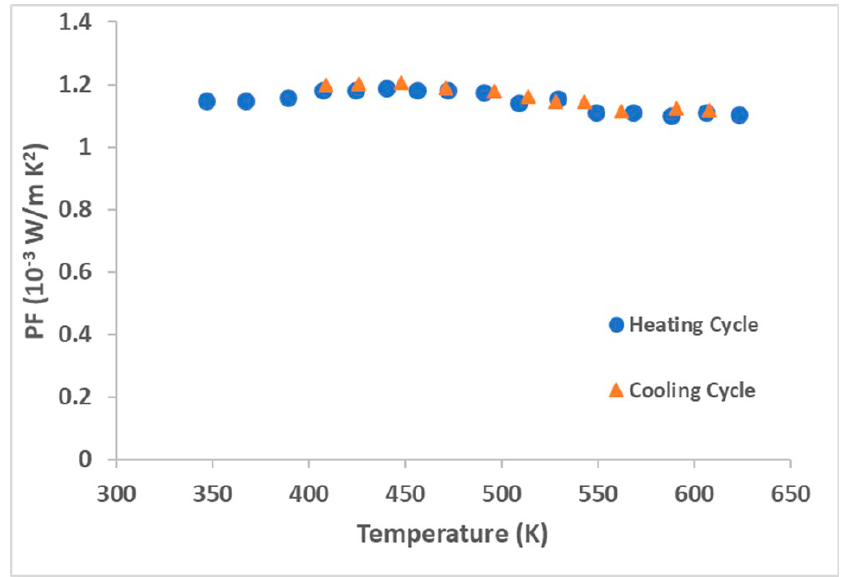
Figure 10. Power factor (PF) of hot extruded ZnSb sample in a heating / cooling Figure 10 . Power factor (PF) of hot extruded ZnSb sample in a heating/cooling cycle.